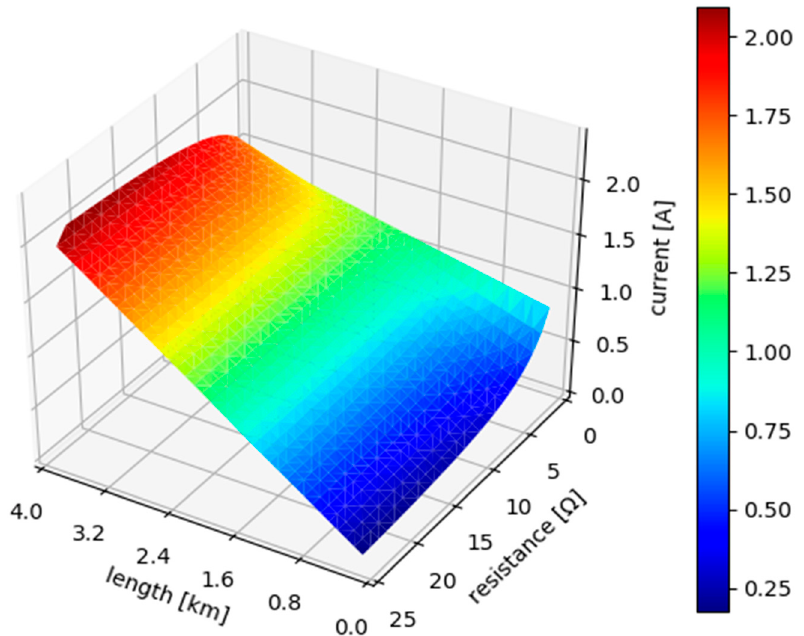
Figure 12. No-load screen current measured at the supply side; formation presented in Figure 2c.